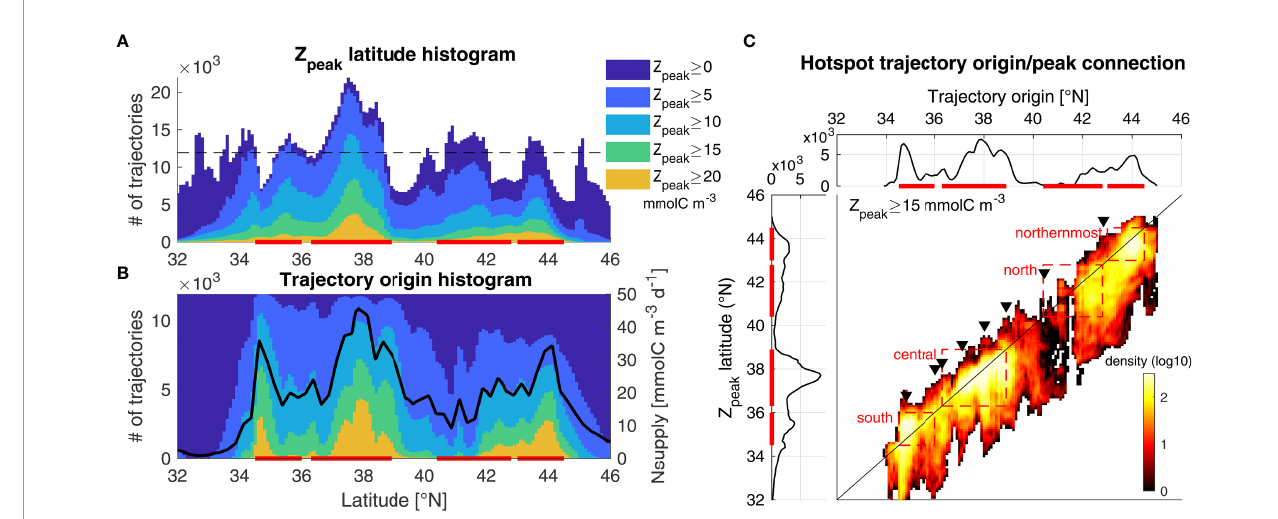
FIGURE 10 | Origin of krill hotspots. The fi gure connects, for each trajectory initialized from April to August, the latitudes of its coastal origin and its Z big peak (Z peak , observed after ~ 3 weeks). (A) Histogram of Z peak latitudes, where dark blue encompasses all trajectories and successive colors restrict trajectories to those where Z peak is above a given threshold. The dashed line represents the number of trajectories initialized at each latitude bin, meaning that waters converge wherever the dark blue histogram (all trajectories) is above and diverge where it is below. (B) Corresponding histogram of water mass origin for the same thresholds. The dark blue histogram is fl at since the same number of trajectories is initialized in each latitude bin. The dark line represents the mean nitrate supply during April-August. (C) Example of connection between Z peak and trajectory origin for the 15 mmolC m -3 threshold (corresponding to the green color in a and b), where the x-axis (and top horizontal panel) is the trajectory origin, the y-axis (and left vertical panel) is the Z peak latitude, and colors indicate the number of corresponding trajectories. Each row in the density plot displays where hotspot water masses at that latitude originated from, and each column displays where Z big peaks along water masses originating from that latitude. Black triangles indicate major capes, from south to north: Pt Conception, Lopez Pt, Pt Sur, Pt Ano Nuevo, Pt Reyes, Pt Arena, Cape Mendocino, and Cape Blanco. The strong upwelling near 44°N is not associated with a cape. The Z peak latitudes were smoothed using a 3-point window in all plots, and histograms were constructed at 1/10° resolution. Red bars highlight the hotspots ’